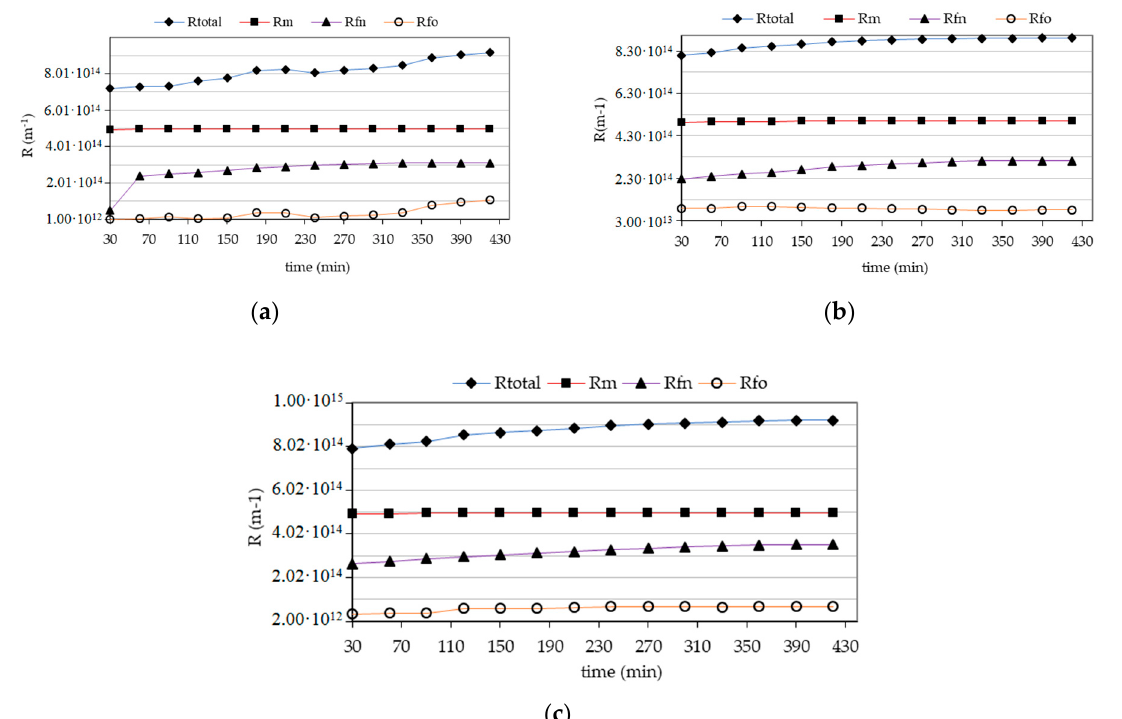
Figure 3 . Dependence of changes in resistance R total , R m , R fo , R fn as a function of time for the membrane during filtration of infiltration water and with increased content of NH 4+ and NO 3– , ( a ) infiltration water, ( b ) infiltration water with NH 4+ , ( c ) infiltration water with NO 3– .